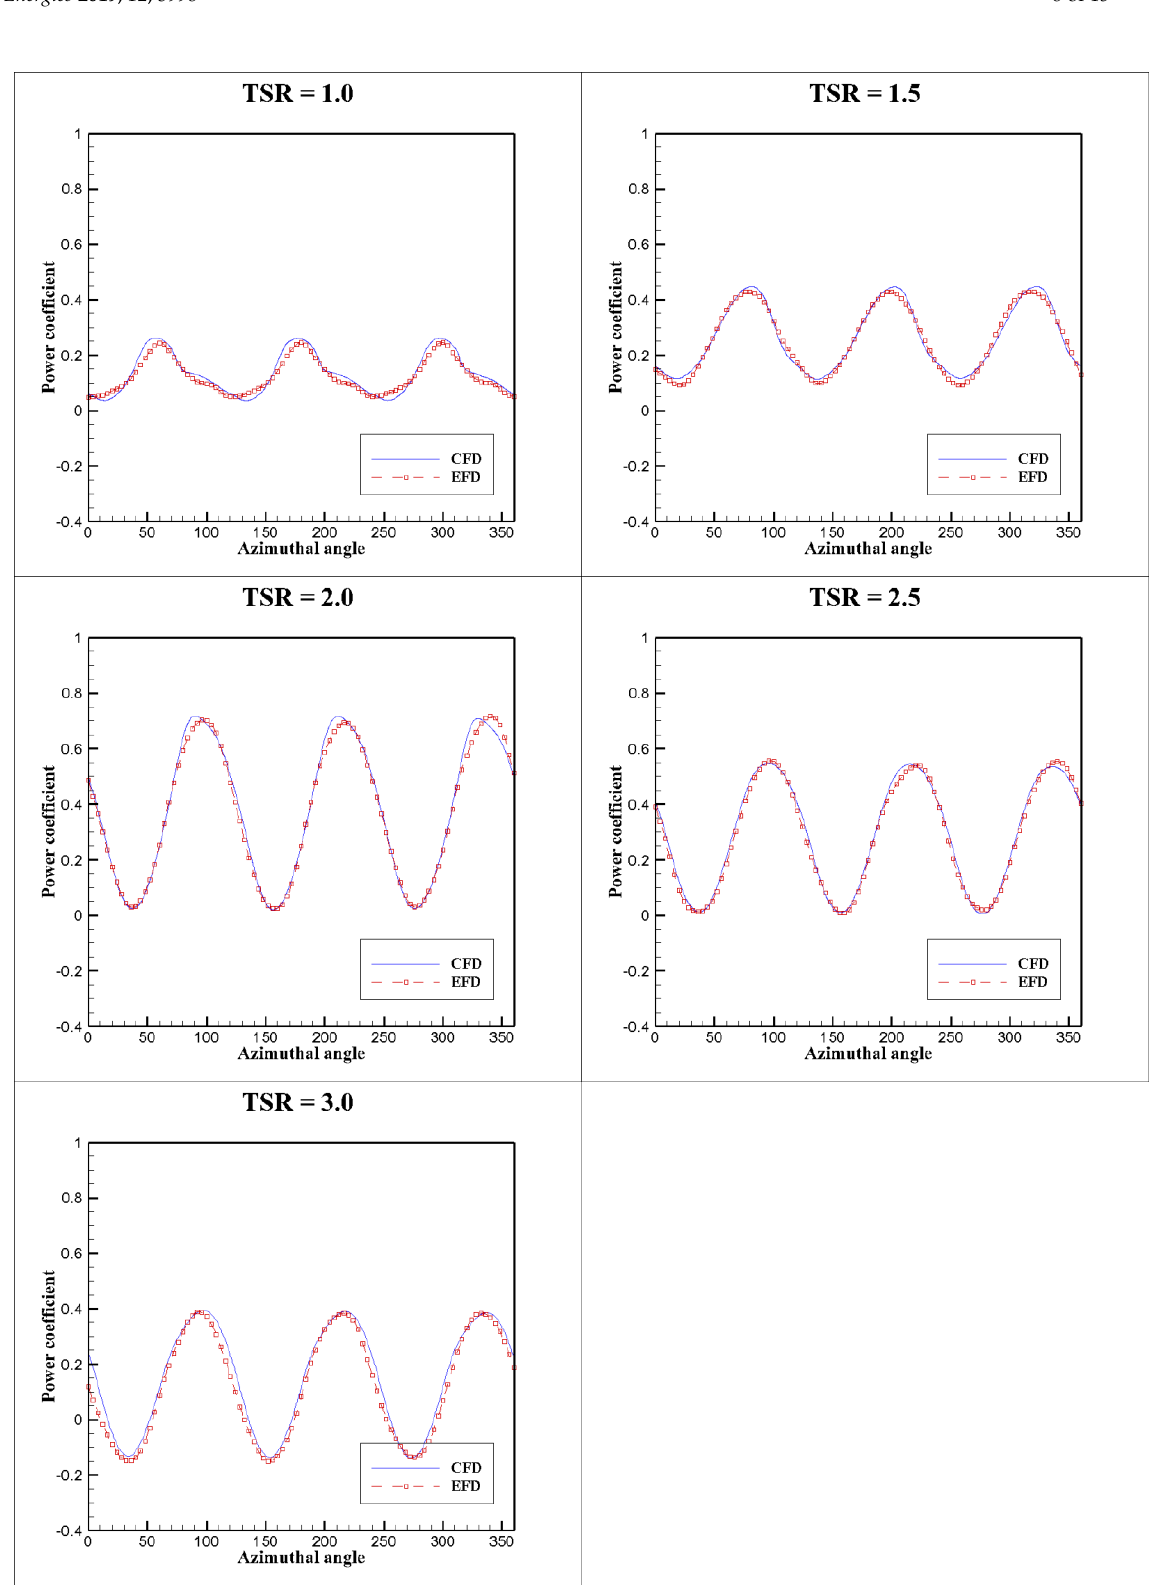
Figure 9. Time histories of C P of the Darrieus turbine at various tip-speed ratios (TSRs).